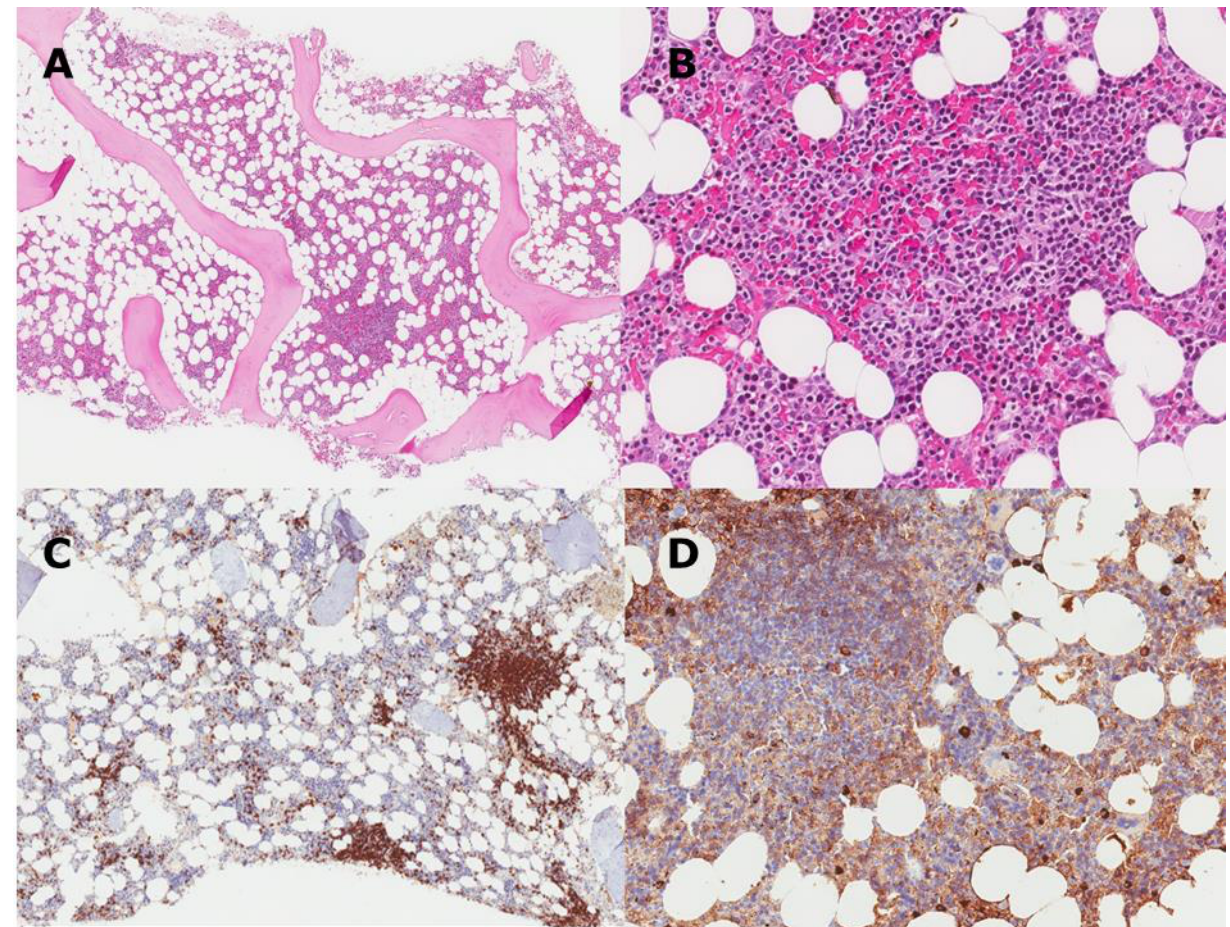
Figure 1. Cold agglutinin-associated lymphoproliferative bone marrow disorder. Panel ( A ): Nodular lymphoid aggregate (HE-staining, 50×). Panel ( B ): Aggregate of small lymphoid cells with round to oval nuclei and scant cytoplasm (HE-staining, 280×). Panel ( C ): CD20 staining shows nodular as well as interstitial infiltration of B-cells (50×). Panel ( D ): IgM-positive B-cells in the infiltrate and scattered IgM-positive plasma cells around the infiltrate and diffusely throughout the bone marrow (145×).